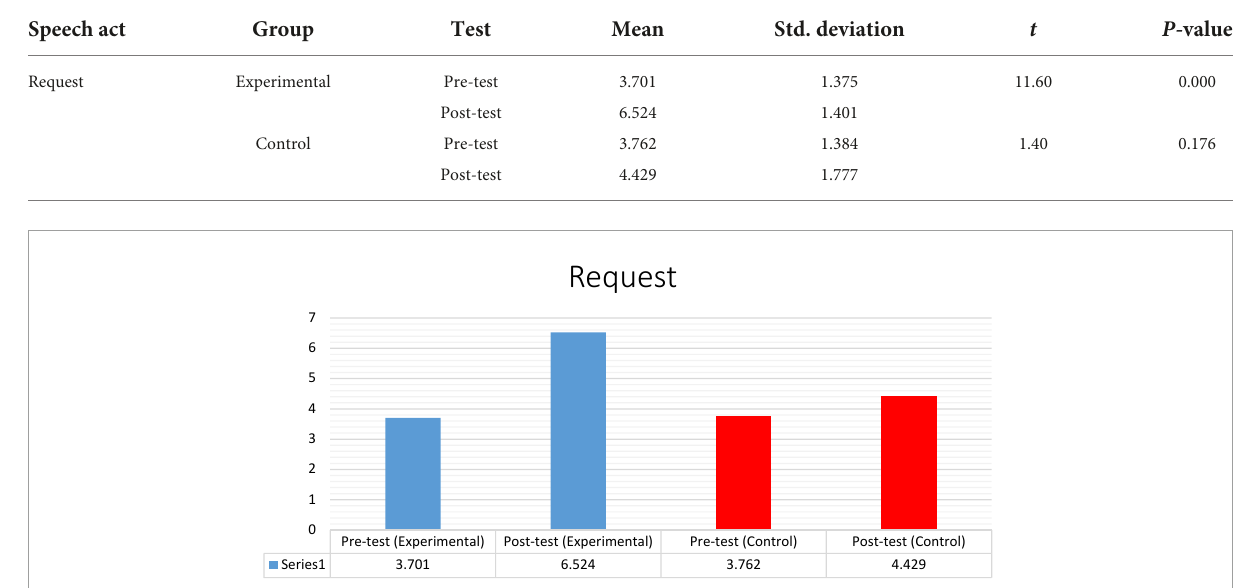
TABLE 4 Paired-samples t -test for experimental and control groups